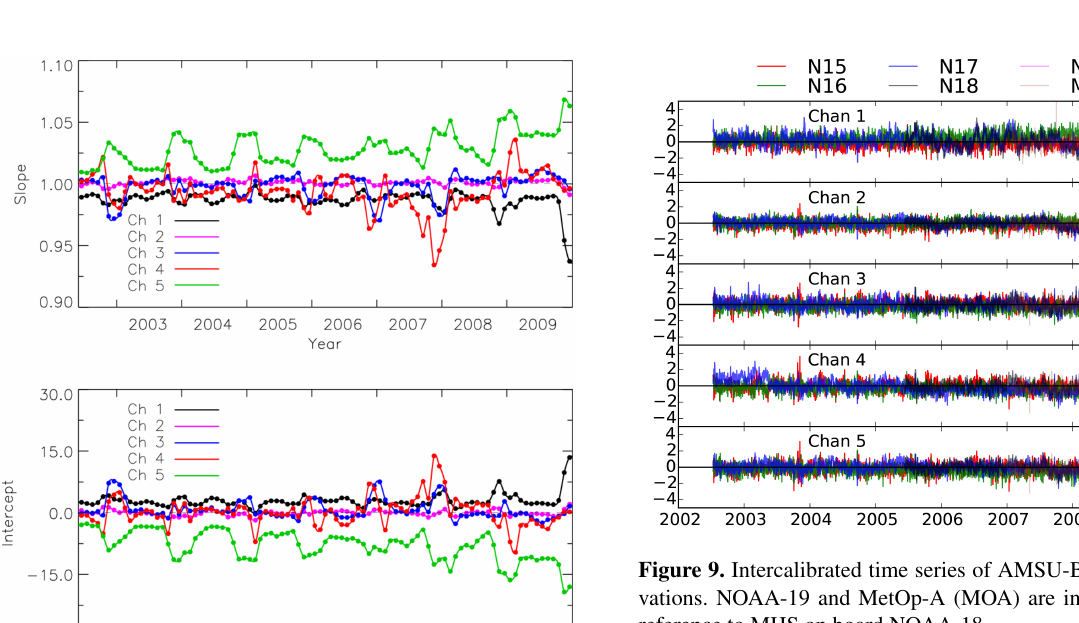
Figure 7. Determining the empirical calibration coefficients using a linear relation between the measurements from the target and reference instruments. (a) – (e) are channels 1–5 from left to right. The solid black line shows the regression line. Different colors show the data for Antarctic (Ant), Arctic (Arc), and tropical (Trop) regions.